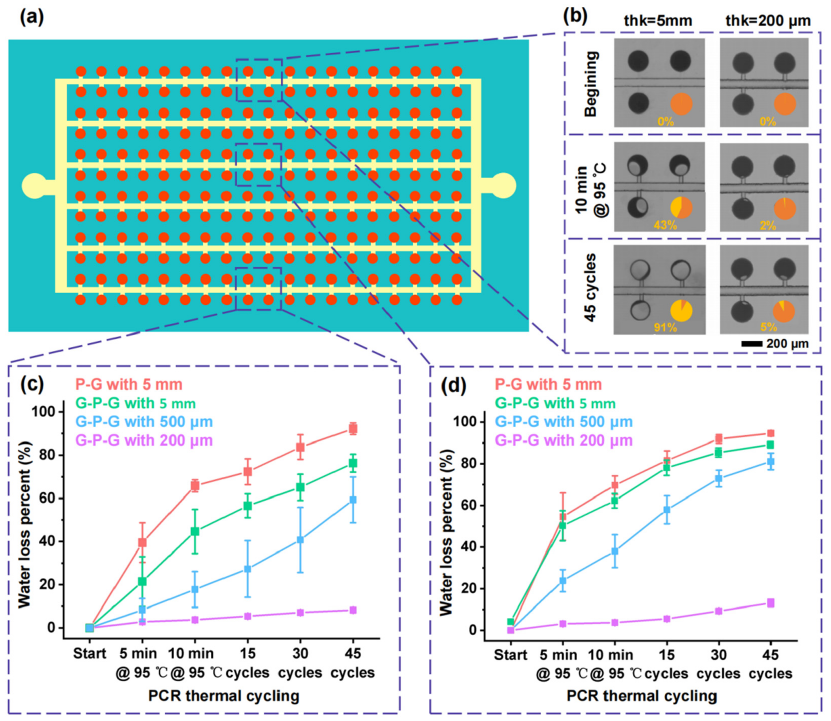
Figure 8. Evaporation result of the central and peripheral chambers in cdPCR MFD: ( a ) location schematic of the central and peripheral chambers in the cdPCR MFD, the red color is the reagent, the yellow one is oil, and the Aquamarine color is PDMS chip. ( b ) Water loss process in the peripheral chambers under PCR thermal cycling of G-P-G MFDs with 5 mm and 200 μ m-thick PDMS films. Water loss percentage in the chambers with PCR thermal cycling in the G-P-G MFD with different PDMS film thicknesses: ( c ) central chambers and ( d ) peripheral chambers.